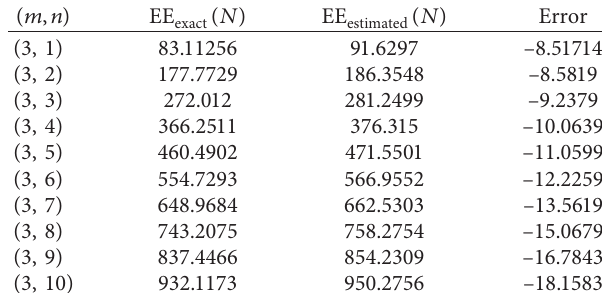
Table 9: The E ( m, n )